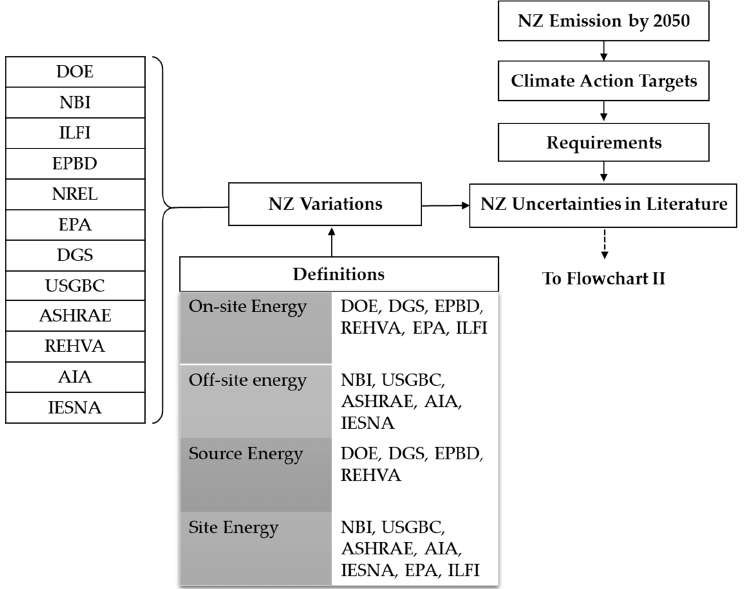
Figure 3. Flowchart I, supply and source requirements variation in net zero definitions.